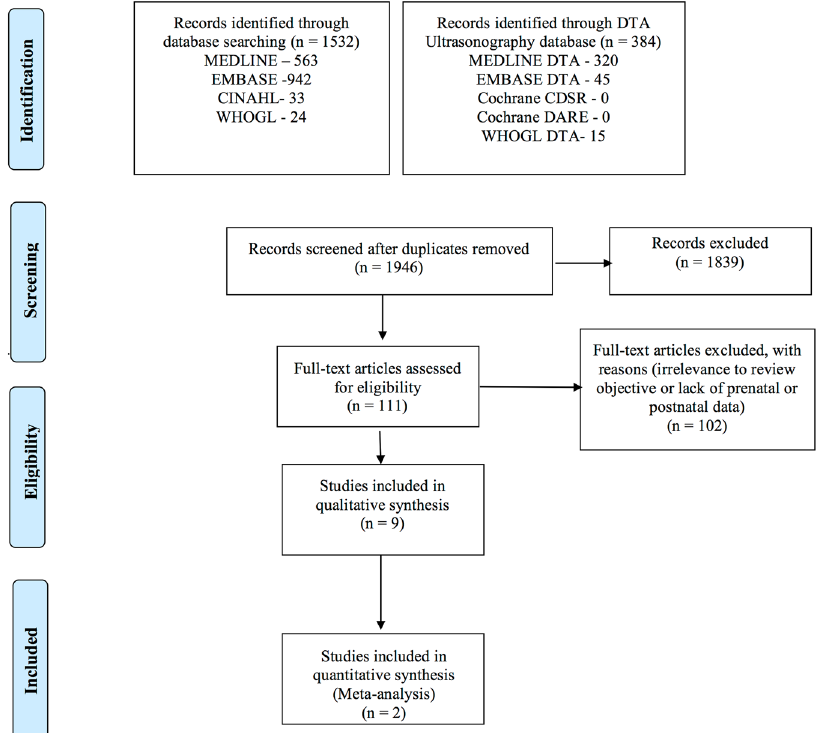
Figure 1. Flow diagram. Search results and study selection (see appendices for